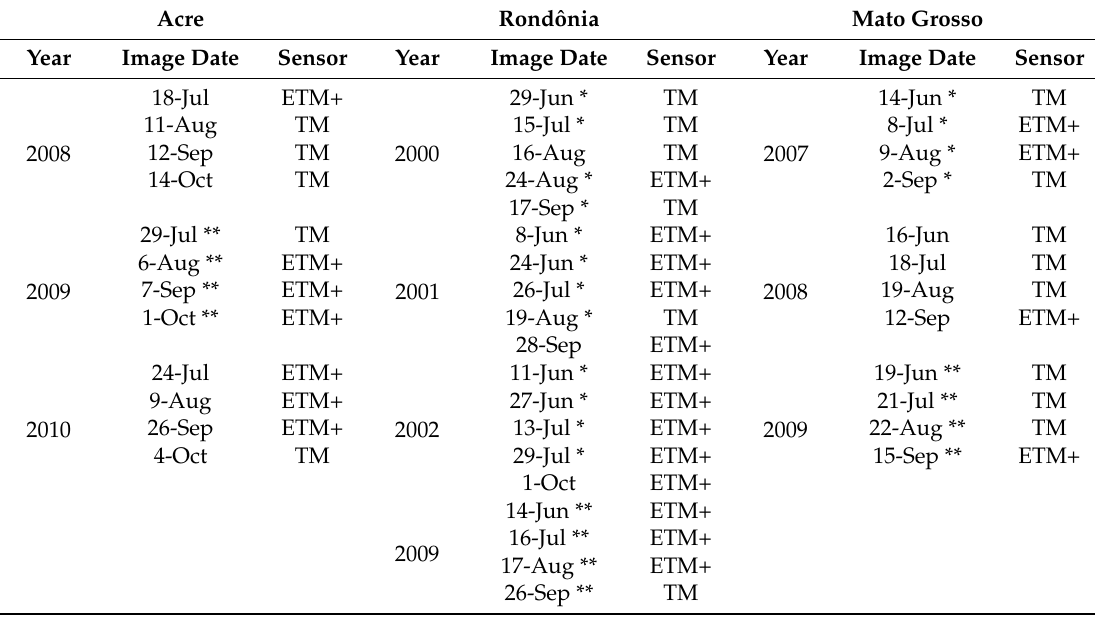
Table 3. Landsat image dates for the three study regions used in this